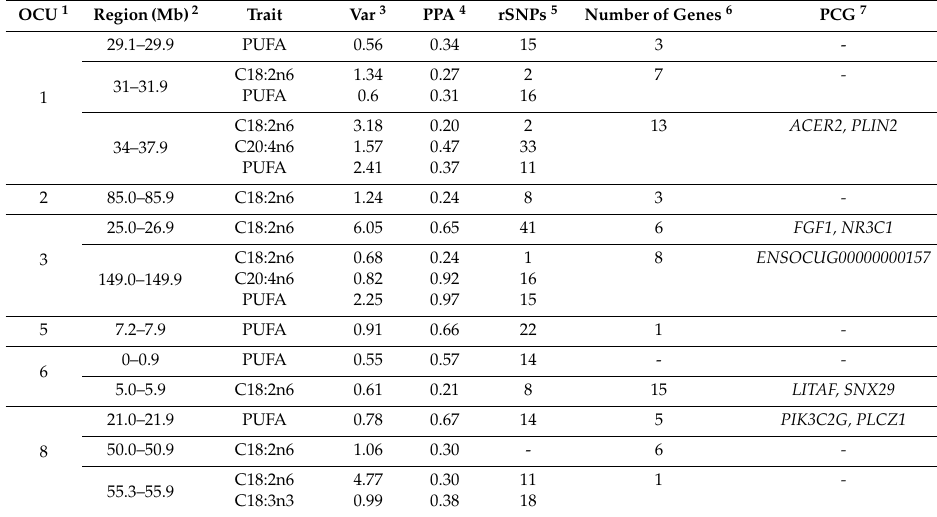
Table 4. Genomic regions associated with polyunsaturated fatty acids of Longissimus thoracis et lumborum muscle in